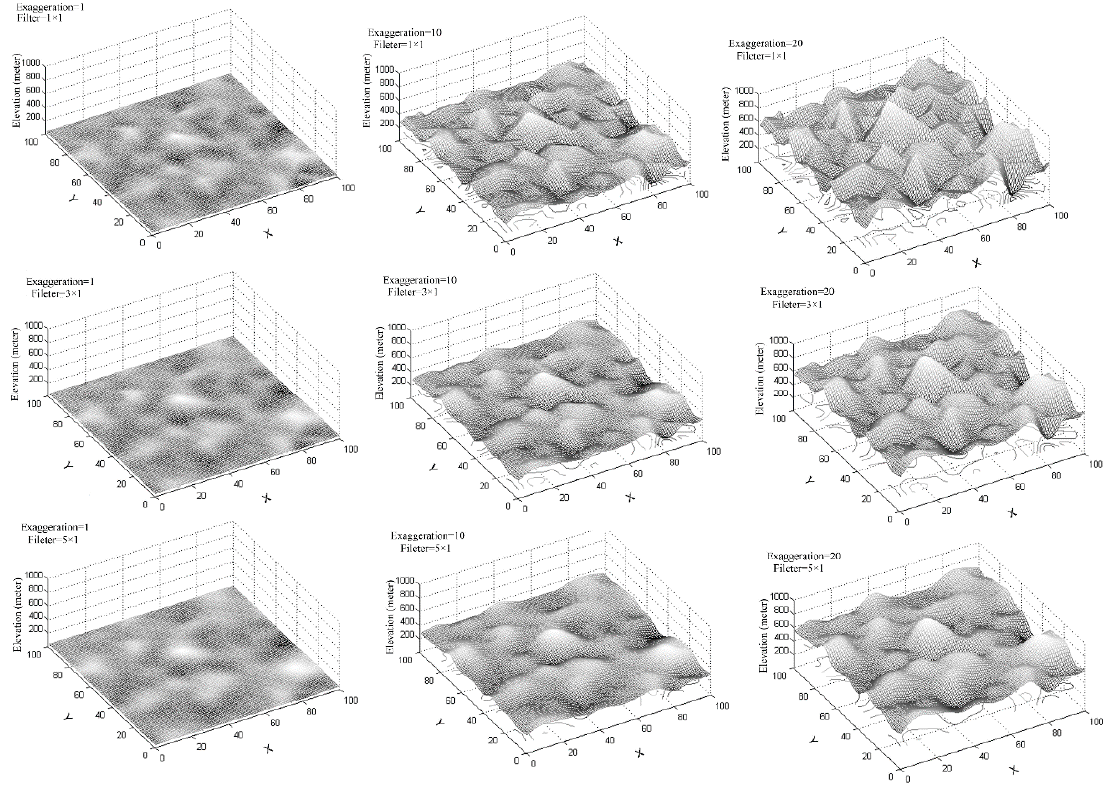
Figure 3. Simulated DEM with Gaussian height distributions.